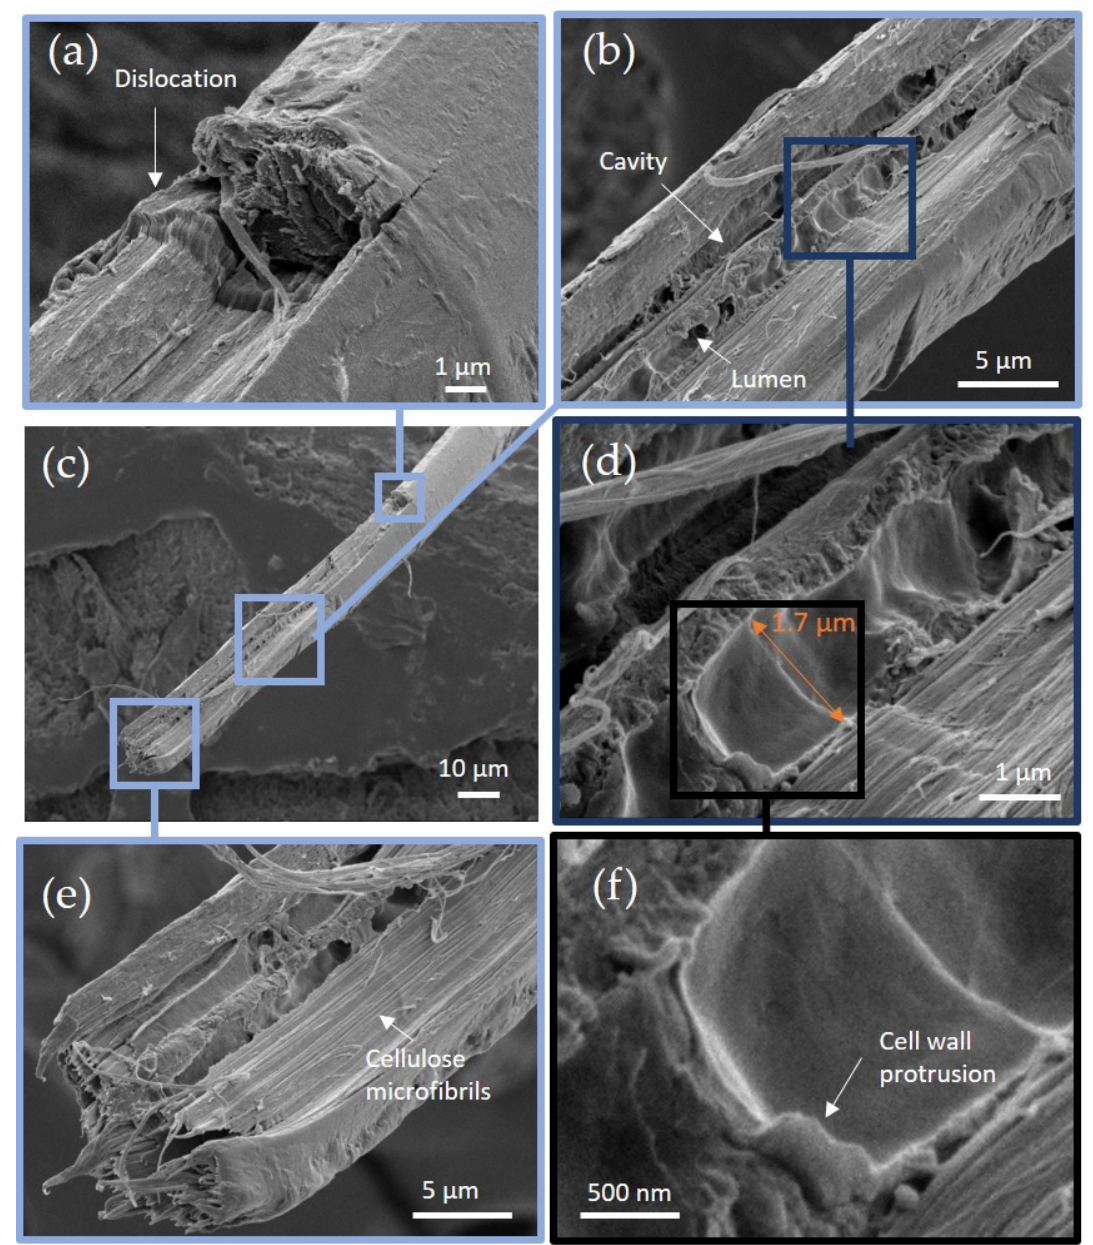
Figure 12. SEM observation of the fracture surface of a flax fibre after tensile testing ( c ) and focus on different areas. ( a ) near a dislocation, ( b ) along the cavity, ( c ) outer view up to the fractured edge ( d ) close view at the damaged area, ( e ) zoom on microfibrils arrangement, ( f ) close view at the cell wall protrusion.